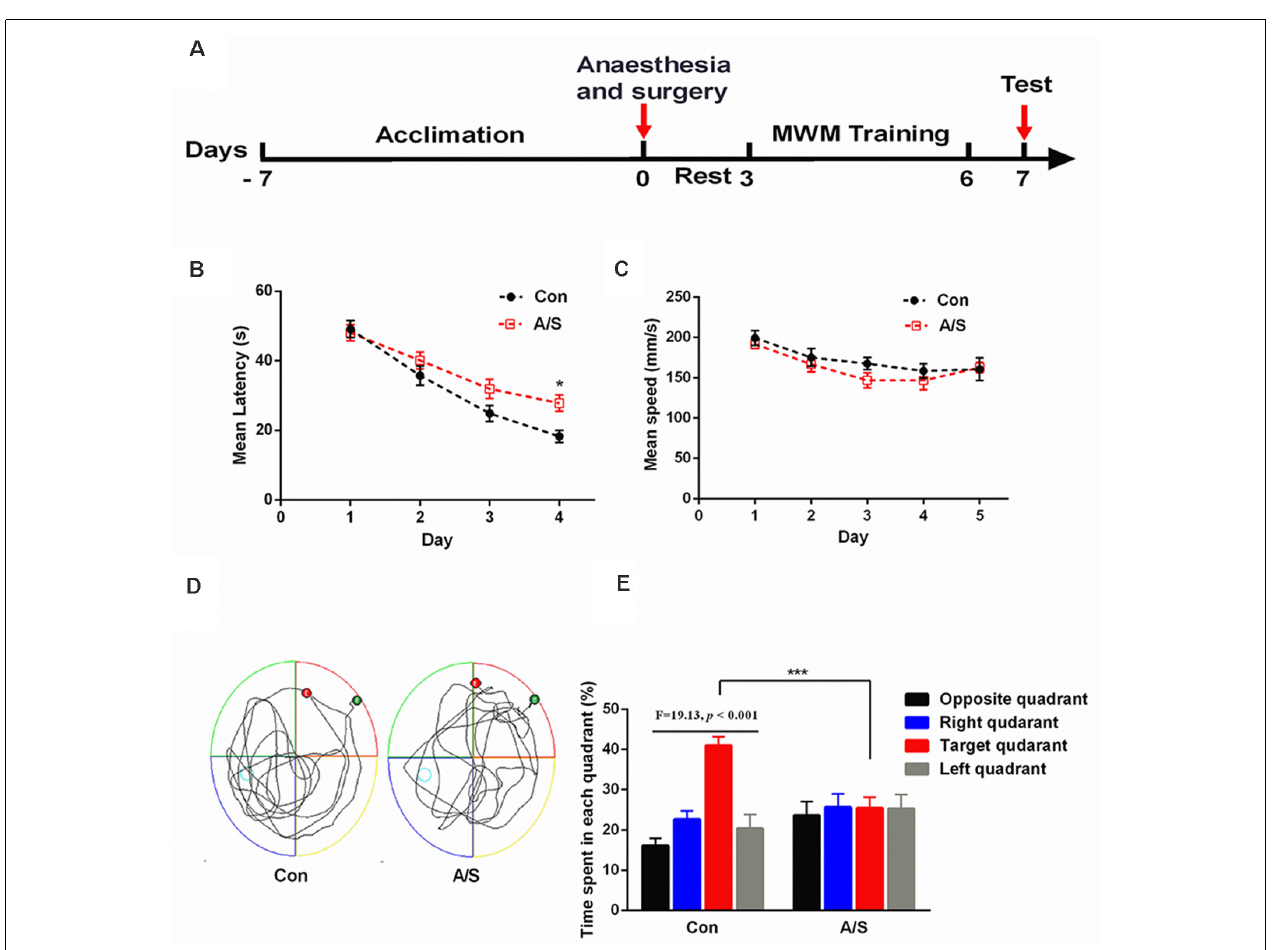
FIGURE 1 | Anesthesia and surgery impaired reference memory in aged mice. (A) Schematic timeline of the experimental paradigm of surgery procedure and Morris water maze test. After the anesthesia/surgical procedure, training was conducted for 4 days followed by probe tests on day 7. (B) Escape latency to reach the hidden platform during the 4-day training; the mean latency of the anesthesia/surgery group was significantly prolonged on day 4 than the control. (C) Average swimming speed; there was no significant difference between the two groups. (D) Representative exploratory path of two groups of mice in the probe test. (E) The percentage of time spent in the target quadrant during the probe test; there was significant difference between the control group and the anesthesia/surgery group. The percentage of time spent in the target quadrant was significantly higher than the other quadrants in control mice. Data are mean ± SEM ( n = 12 per group). *** p < 0.001 vs. Con. Con, control group; A/S, anesthesia/surgery group.